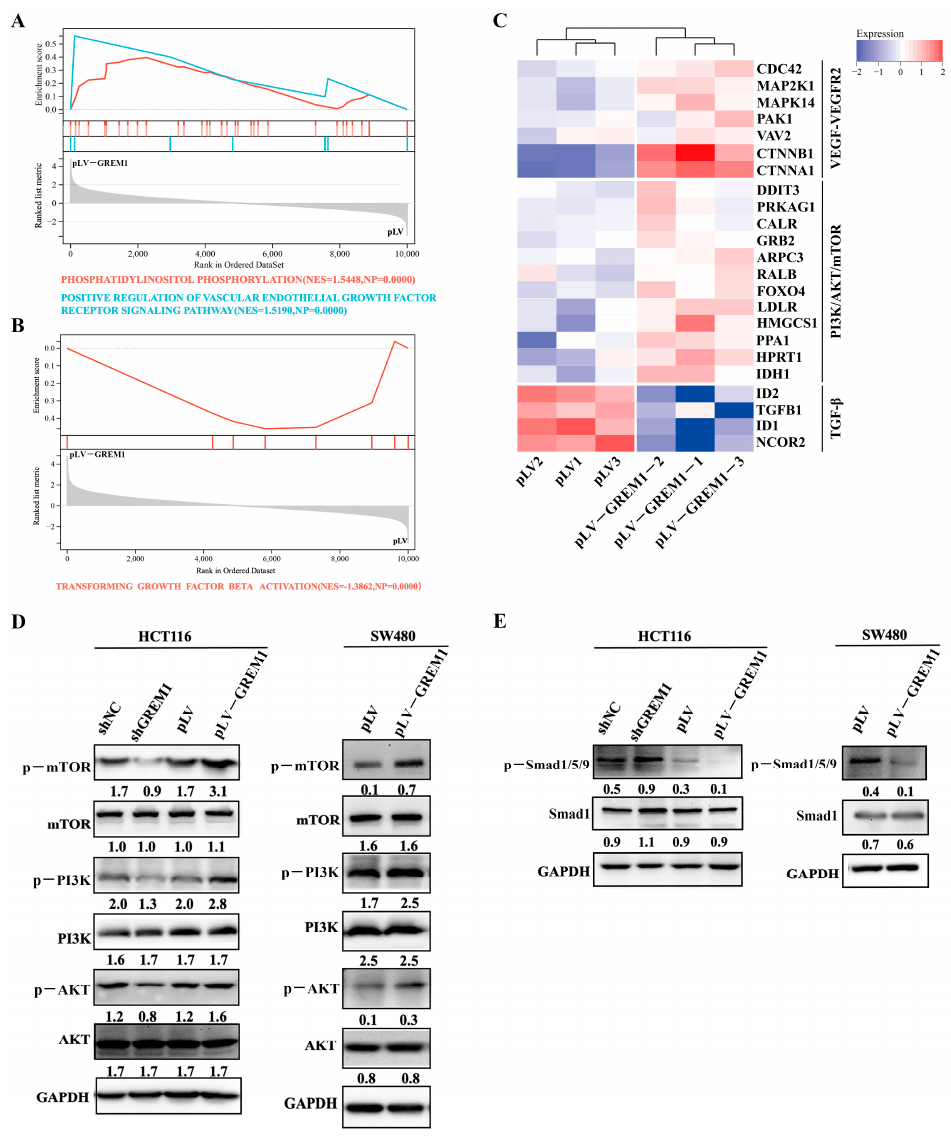
Figure 6. GREM1 negatively regulates ATF4 and but positively regulates ATF6 via suppressing BMP and activating the VEGF-PI3K-AKT signaling pathways. ( A , B ) GSEA of RNA-seq data showed enriched gene sets associated with VEGF/VEGFR2, PI3K/Akt/mTOR and TGF β signaling pathways annotated in the KEGG by comparing GREM1 overexpression versus negative control CRC cells. ( C ) Heatmap showing gene expression differences in the pertinent signaling pathways. ( D , E ) Western blotting analysis revealed the expression of proteins involved in the pertinent signaling pathways.